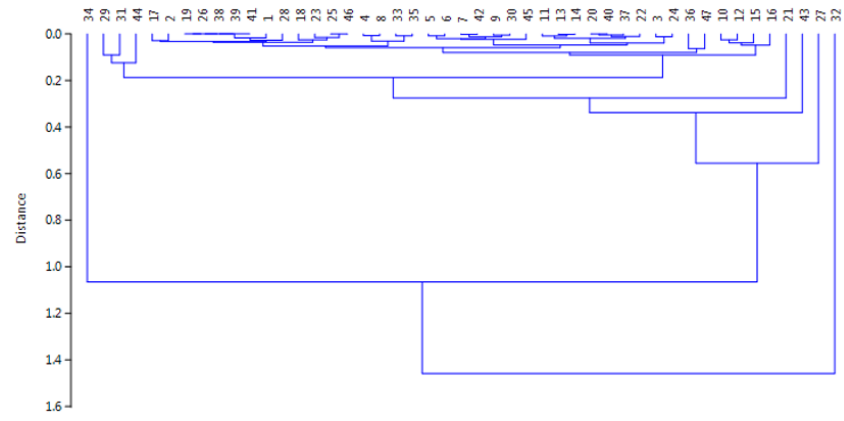
Figure 4. Dendrogram showing the similarities among the samples investigated in this study.